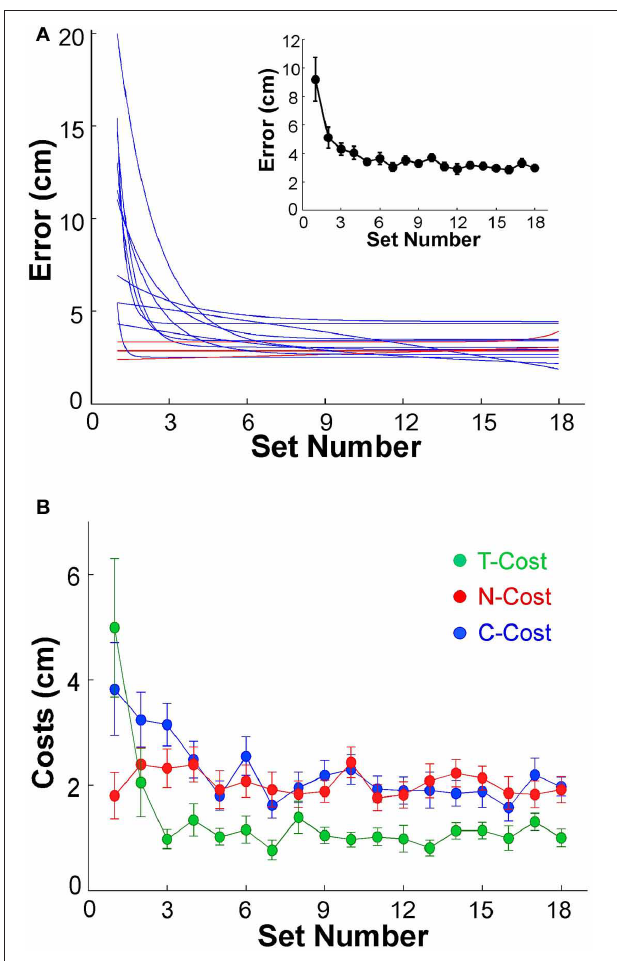
FIGURE 4 | (A) Performance errors for all 13 participants across 18 sets of 60 trials each. The blue and red lines represent the exponential fits for all 13 individuals. Red lines indicate the three subjects that did not show any improvement across practice. The insert shows the average error across all 13 subjects; the error bars denote standard errors across participants. (B) Participant averages of T-Cost, C-Cost, and N-Cost across all 18 sets in the 6 days of experiments.